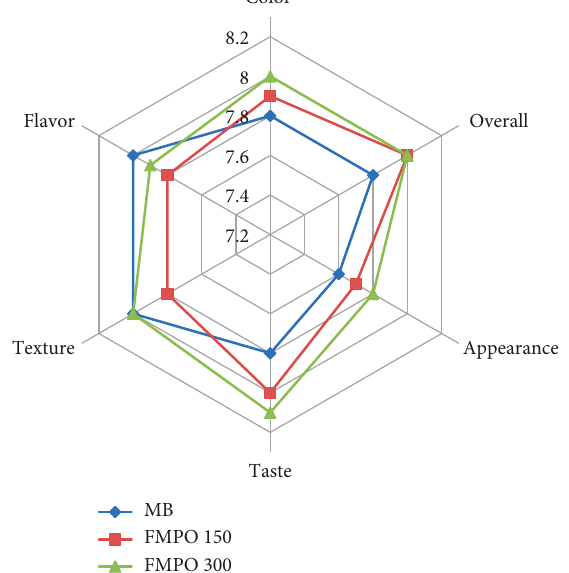
Figure 2: Sensory properties of functional milk beverages; FM, FMPO 150 and FMPO 300. FM: the control fermented milk beverage; FMPO 150: fermented milk beverages supplemented with pome- granatepeel extract (150mg/L);FMPO 300: fermentedmilk beverages supplemented with pomegranate peel extract